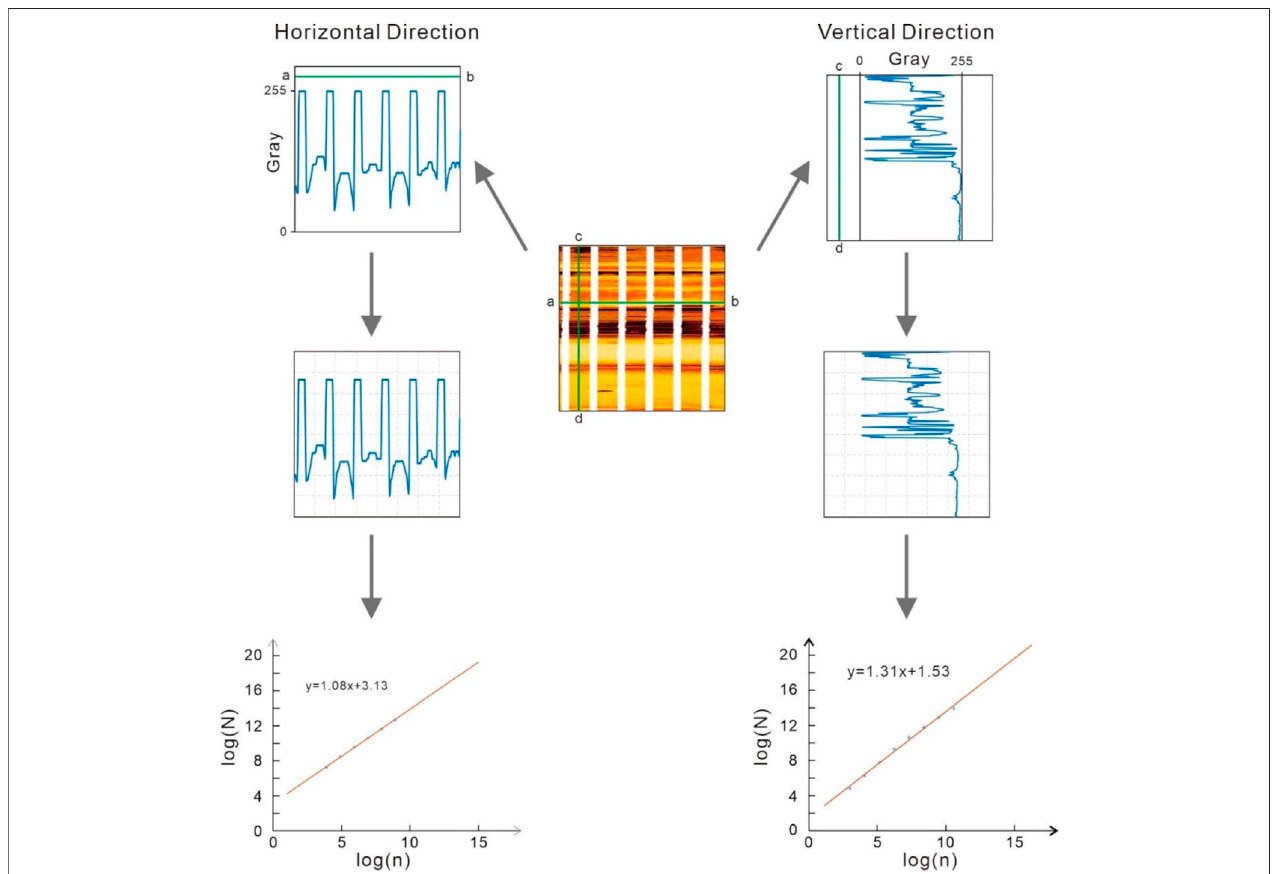
FIGURE 4 | Calculation fl ow of fractal box dimension in different directions of imaging logging map.